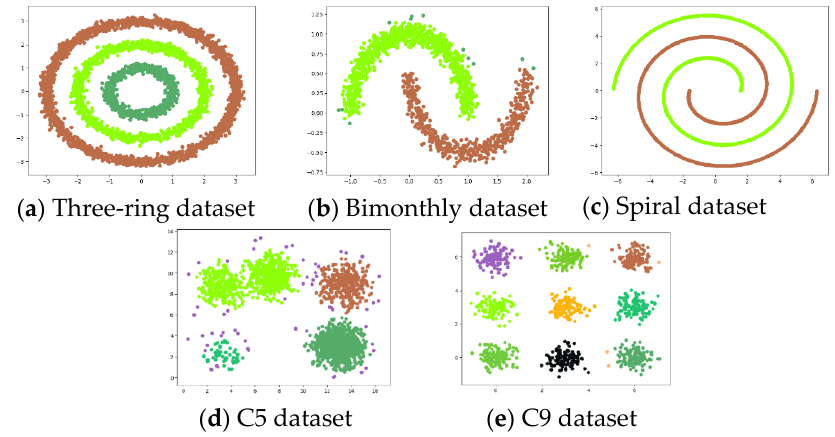
Figure 4. Clustering results of PRI-MFC algorithm on artificial datasets.